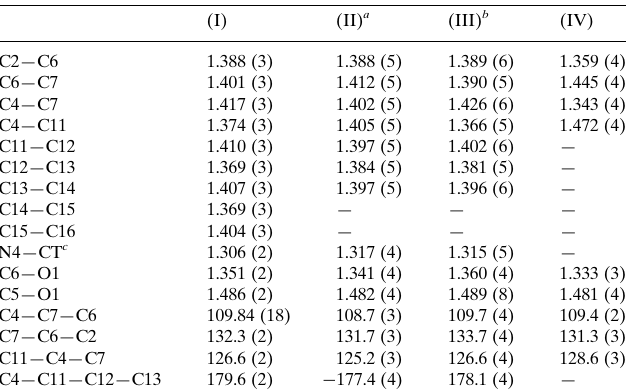
Selected bond lengths and angles (A˚ , (cid:4) ) in the title compound and related compounds. Compound (I) is the title compound, (II) is the closely related buta-1,3-dienyl equivalent (Gainsford et al. , 2008 c ), (III) is the piperidin-1-yl equivalent of (II) (Gainsford et al. , 2008 b ) and (IV) is the starting acceptor molecule 2- dicyanomethylene-4,5,5-trimethyl-2,5-dihydro-furan-3-carbonitrile (Li et al.